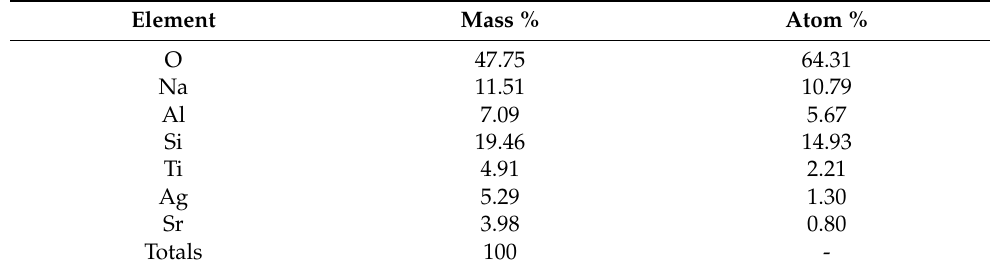
Table 3. Elemental analysis for Ag-TiO 2 /Sr 4 Al 14 O 25 :Eu 2+ ,Dy 3+ photocatalyst/phosphor beads.